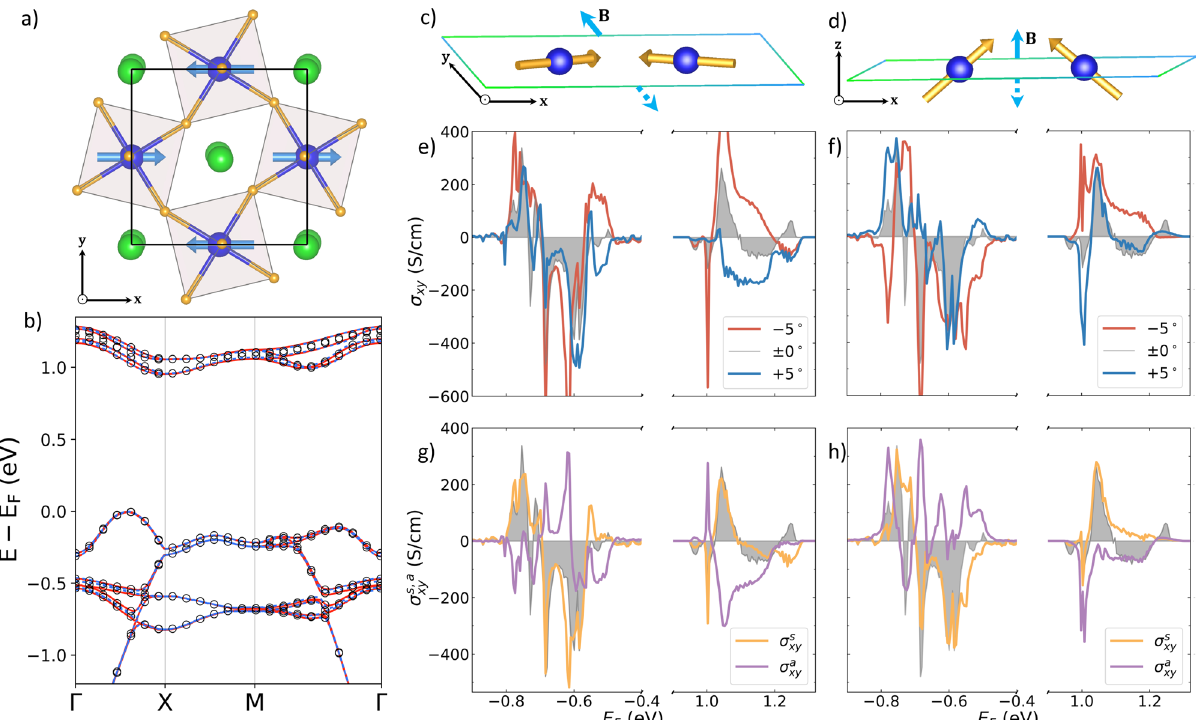
Fig. 5 Chiral and crystal Hall effect in monolayer of antiferromagnetic SrRuO 3 (SRO). a Top view of the monolayer with staggered magnetization along x . Green, blue and orange spheres mark Sr, Ru and O atoms, respectively, with arrows representing Ru spins. Visible is the octahedral distortion of oxygen cage surrounding Ru atoms (rotation in the xy -plane and tilt with respect to the z -axis). b Band structure of SRO monolayer with spins along x (black line, open circles), and in the canted state with canting angle of θ = ±5° in the xy -plane with respect to the x -axis (green and red lines for positive and negative chirality, respectively). c Schematic of the geometrical setup: Canted state considering the canting angle θ = ±5° in the plane of the SRO fi lm ( xy -plane) with respect to the x -axis. d Same as in c for the xz -plane of canting along z . e, f Computed anomalous Hall conductivity (AHC) as a function of Fermi level position in the collinear (along x ) as well as in the canted state. The corresponding geometrical setup is shown schematically in c and d respectively. Shaded gray areas corresponds to the AHC in the initially collinear state, σ 0 xy , while blue and red lines mark the AHC for positive and negative chirality. g , h The symmetric, σ s xy (violet line), and antisymmetric, σ a xy (orange line) parts of the AHC are shown on the background of the AHC in the collinear state (shaded area). While the crystal Hall effect ( σ s xy ) of SRO displays little variation with the canting plane, the chiral Hall effect ( σ a xy ) is extremely sensitive to the interplay of crystal symmetries and